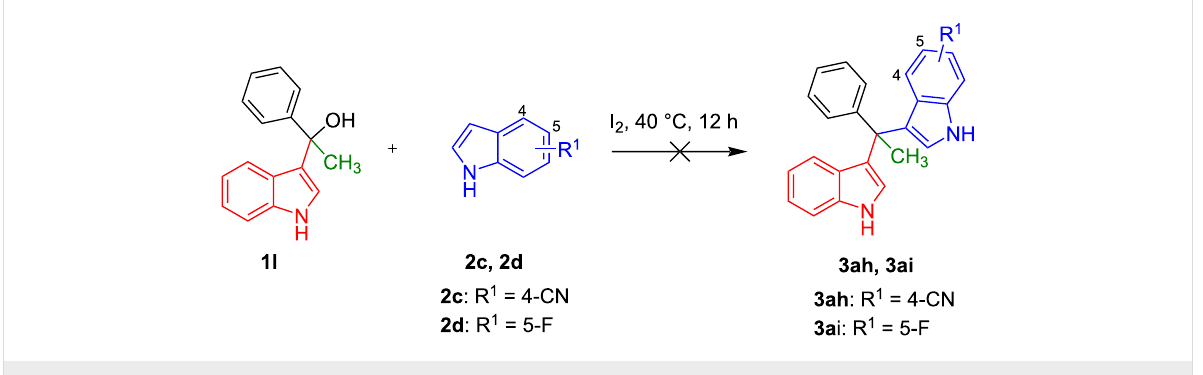
Figure 3: Reactions performed to study the scope of the method.